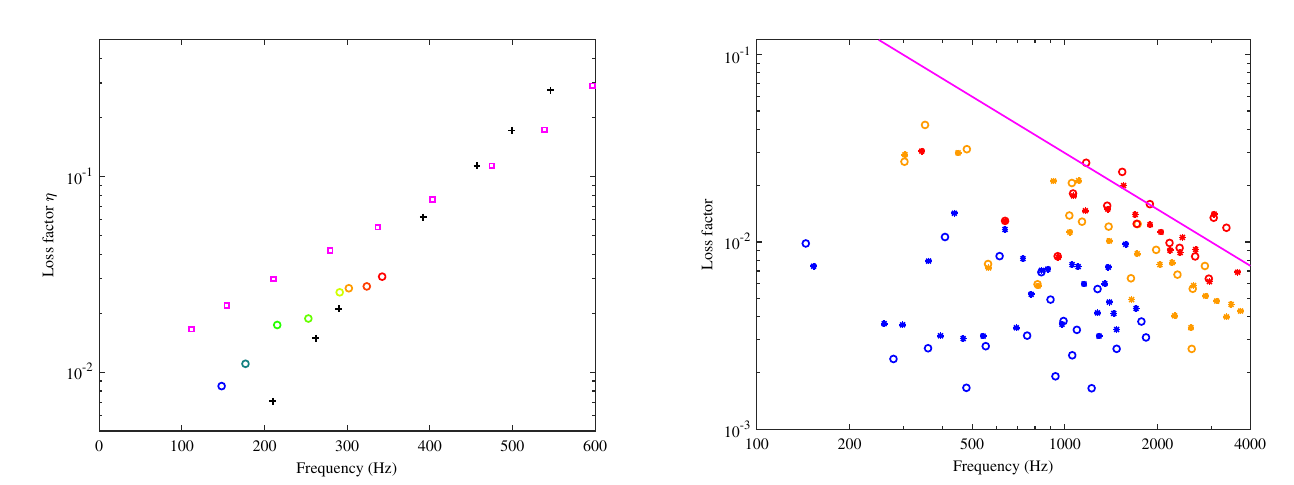
Figure 9. Results for variations of head tension: loss factor against frequency for the fundamental mode of the membrane with the eight tension settings (circles, tensions indicated by colour as in Fig. 8), compared to computed values of frequency and radiation damping from the FE/BE model (black plus symbols) and the rectangular membrane model (magenta squares).